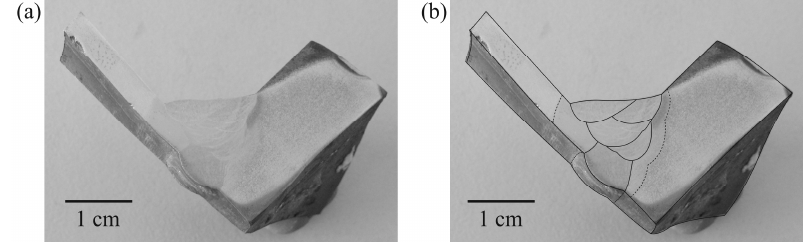
Table 2. Chemical composition of the five zones of the weld analyzed by EDS. Composition (wt.%) Zone Fe Cr Mo 97.01 A